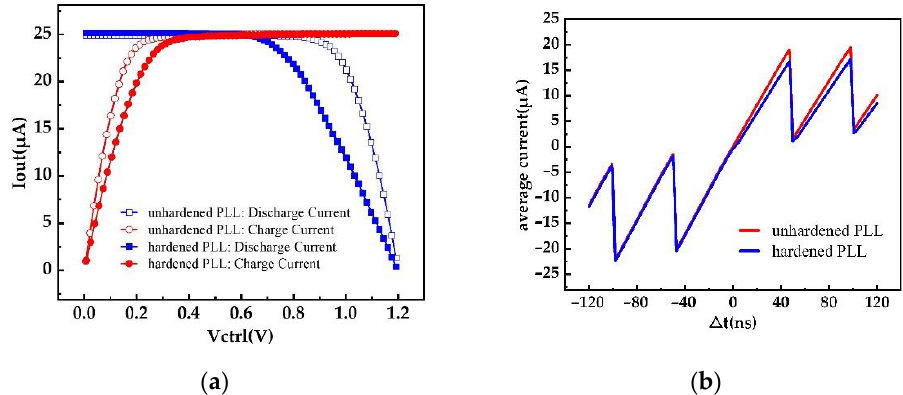
Figure 9. ( a ) Current mismatch of the RHPLL and NHPLL. ( b ) Current linearity of the RHPLL and NHPLL.